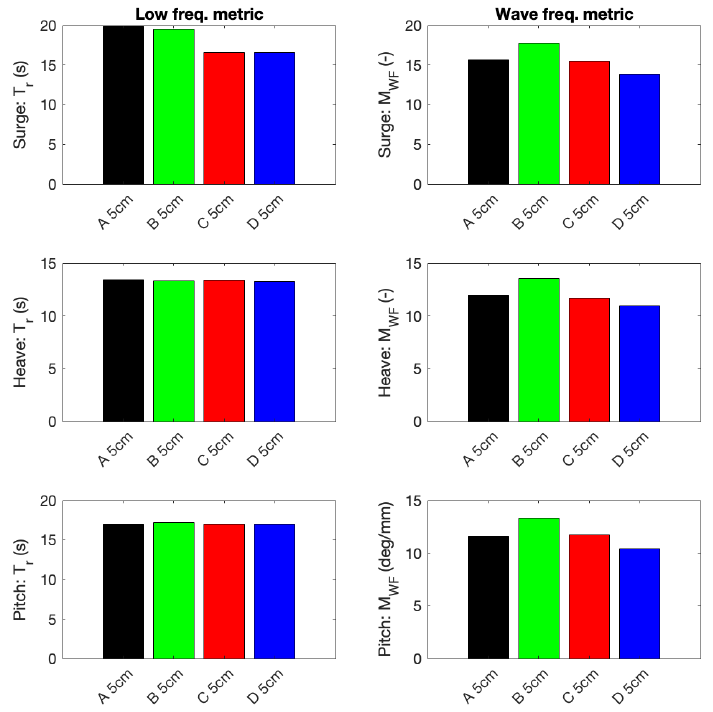
Figure 8. Metric T r (left column) and M WF (right column) for JONSWAP T p = 1.29, H s = 5 cm for all facilities given for surge (top row), heave (middle row), and pitch (bottom